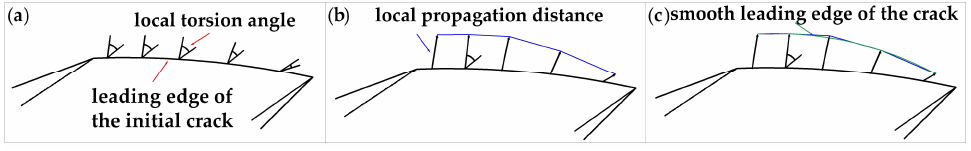
Figure 21. Fatigue crack propagation prediction: ( a ) local torsion angles determination; ( b ) local propagation distance determination; ( c ) smoothen the leading edge.